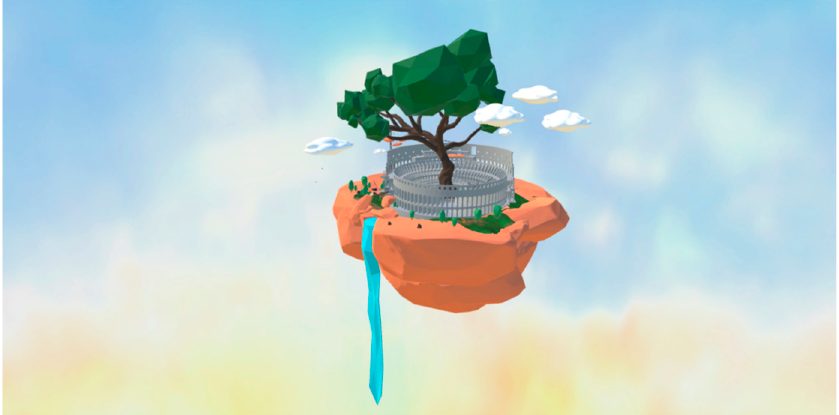
Figure 2. Low polygon-styled semi-surreal Roman Arena scene.